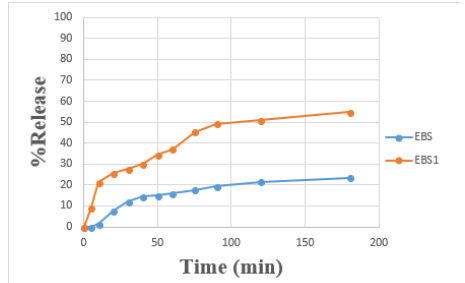
Figure 3. The release profile of pure drug (EBS) and SCAs (EBS1) in 0.1 N HCl at 37°C